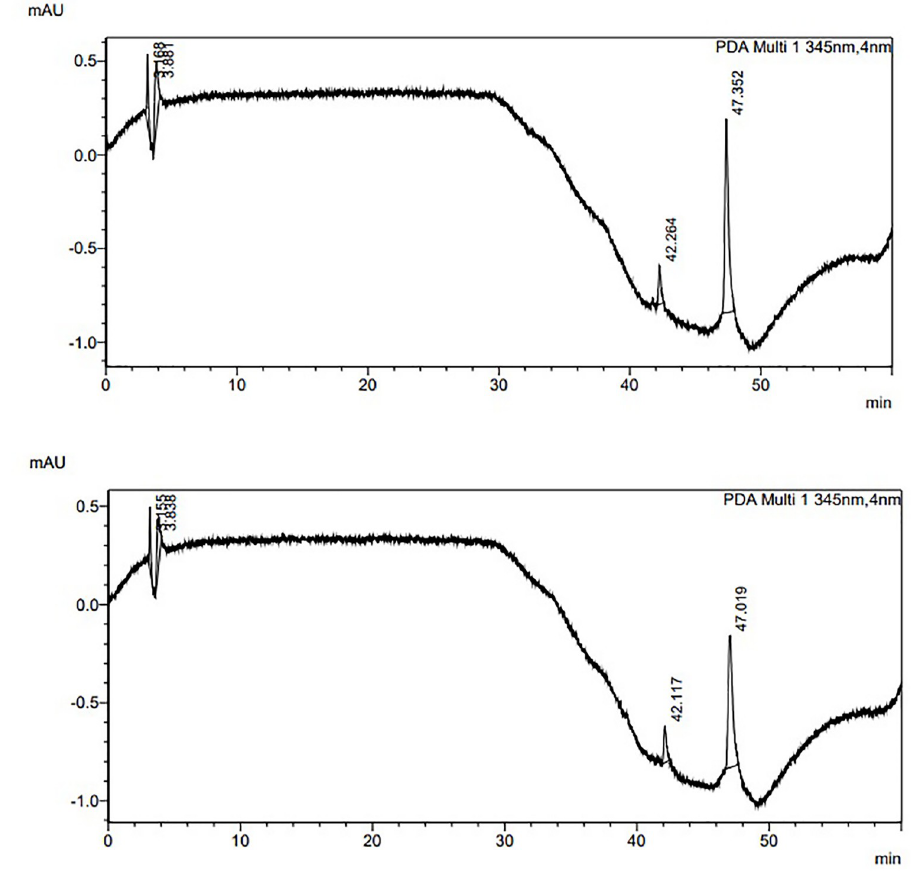
Fig 1. Chromatogram of bee venom. ( A ) Standard mixture; and ( B ) Sample mixture.